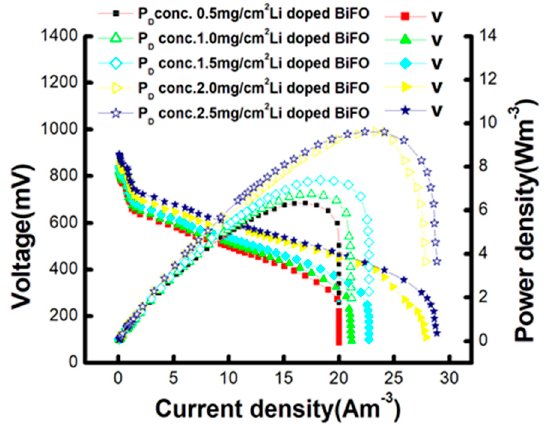
Figure 10. Polarization curve with open circuit potential and power density measurements at variable external resistance (R ext ). The voltage and power density data points are presented as solid and open symbols. A fixed quantity of graphene (0.3 gm/cm 2 ) was loaded to different conc. of BiFe 1 − x Li x O 3 support for the comparison.